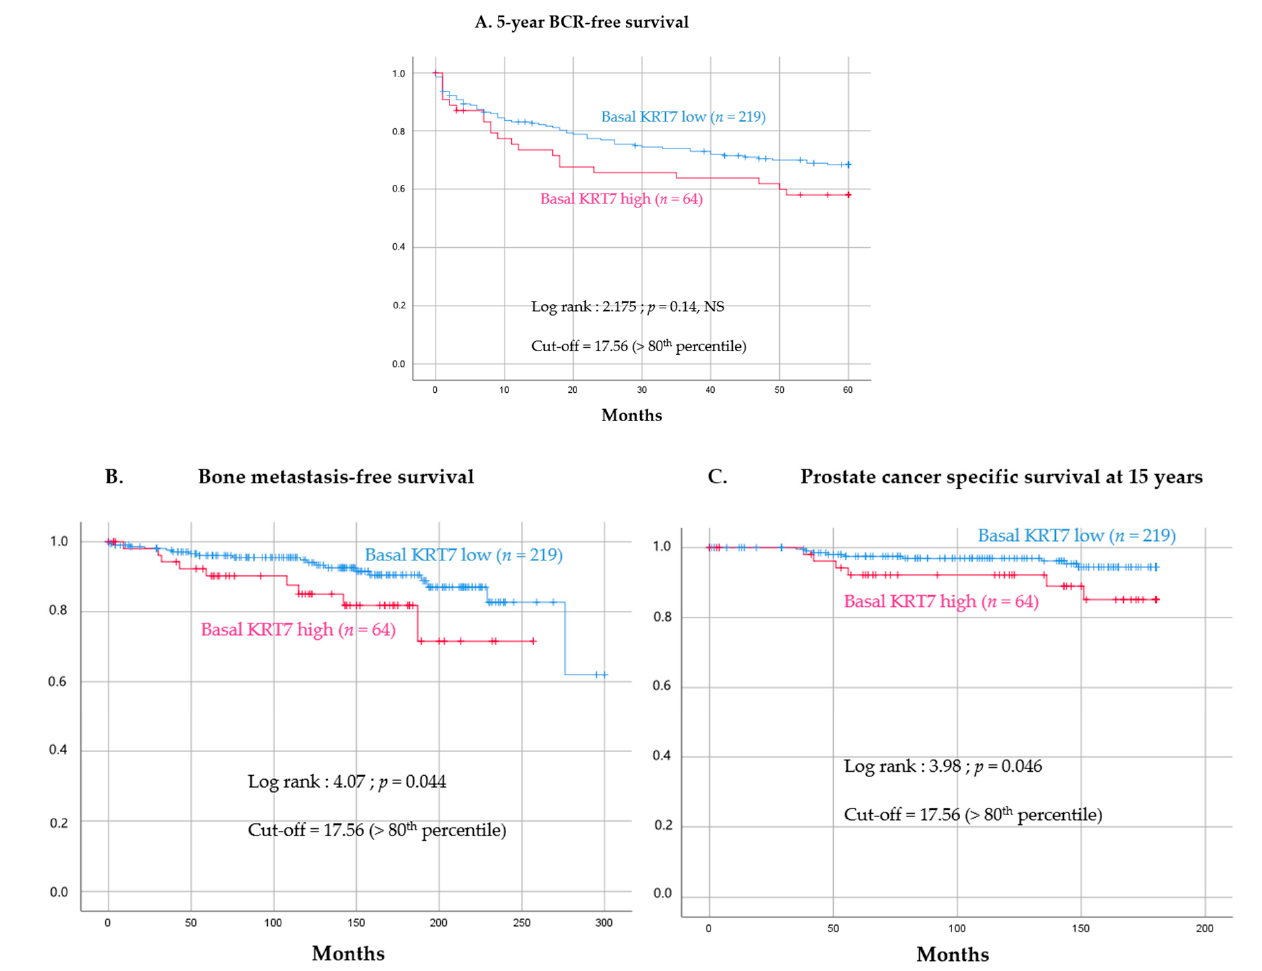
Figure 5. Association of KRT7-high expression (>80th percentile) in basal epithelial cells from benign peri-tumoral glands with survival. ( A ) Association of KRT7-high expression with patient risk of 5year-biochemical recurrence; mean time estimation: 41.2 months (CI 95%: 34.6–47.8) for the